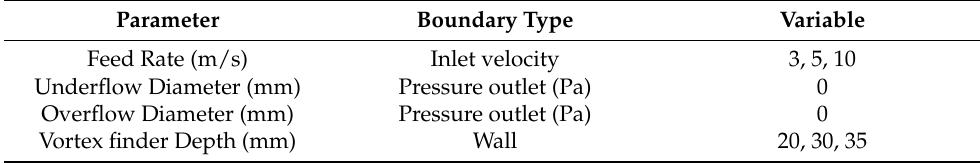
Table 3. Geometry and boundary conditions of hydrocyclone of base case.